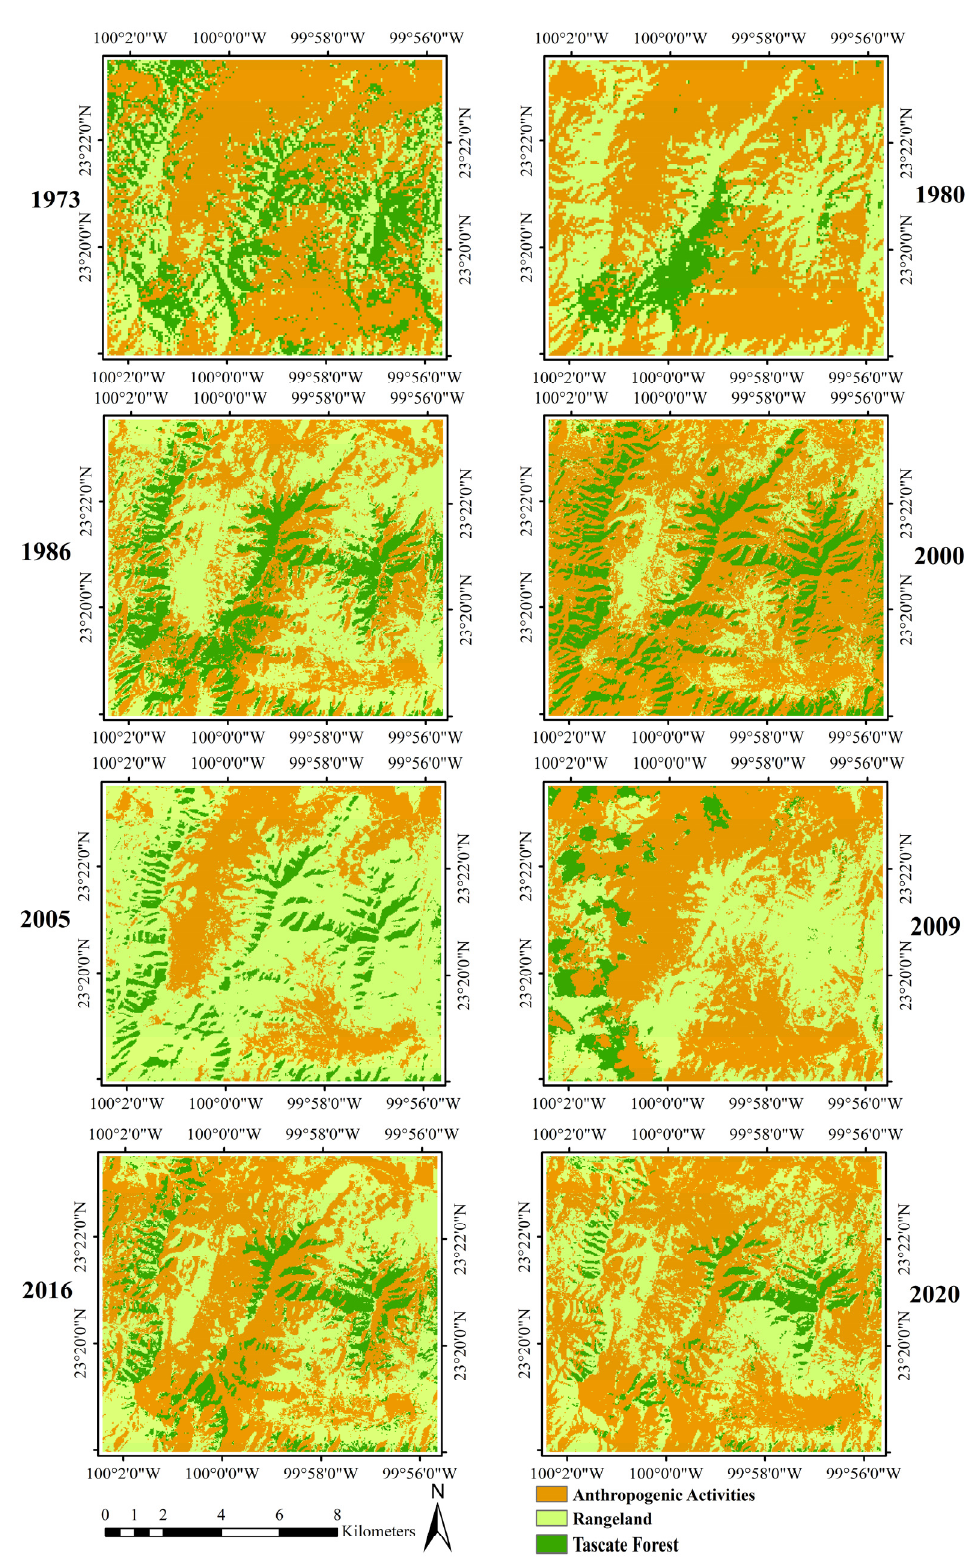
Figure A5. Land use coverage in 1973, 1980, 1986, 2000, 2005, 2009, 2016, and 2020, El Llano y Anexas, Bustamante, Tamaulipas, Mexico.